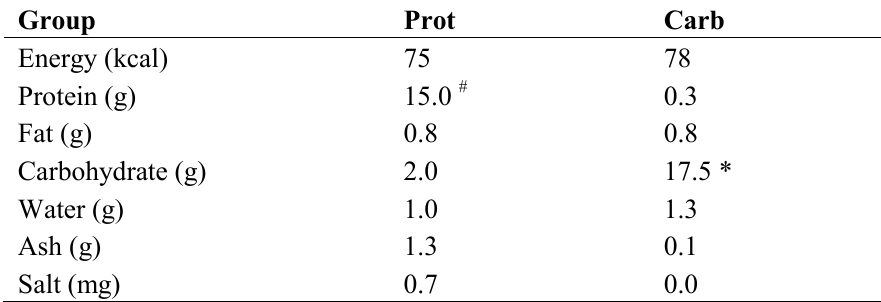
Table 1. Supplement compositions. Participants took 20 g/day of each supplement during the 8-week study period. Supplements were delivered as dry powder in sealed packages and identified by a number code to ensure study blinding. Supplements were stored in a refrigerator until use and reconstituted with 200 mL of mineral water prior to intake (20